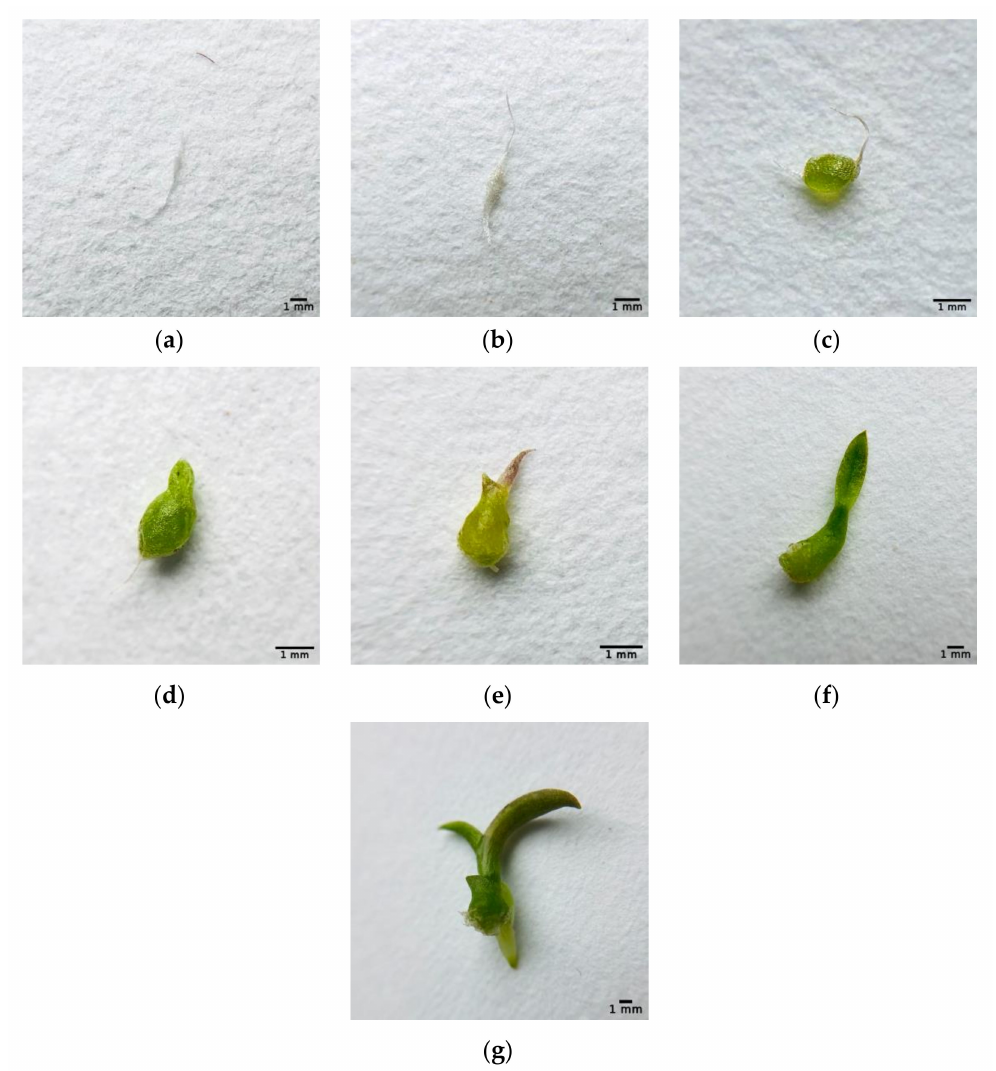
Figure 2. Stages in the development of E. radicans protocorms. ( a ) Stage N 0, no germination. ( b ) Stage N 1 , production of rhizoids by the embryo. ( c ) Stage N 2 , rupture of testa by the enlarged embryo. ( d ) Stage N 3 , appearance of the promeristem. ( e ) Stage N 4 , appearance of the first true leaf. ( f ) Stage N 5 , elongation of the true leaf. ( g ) Stage N 6 , appearance of the second true